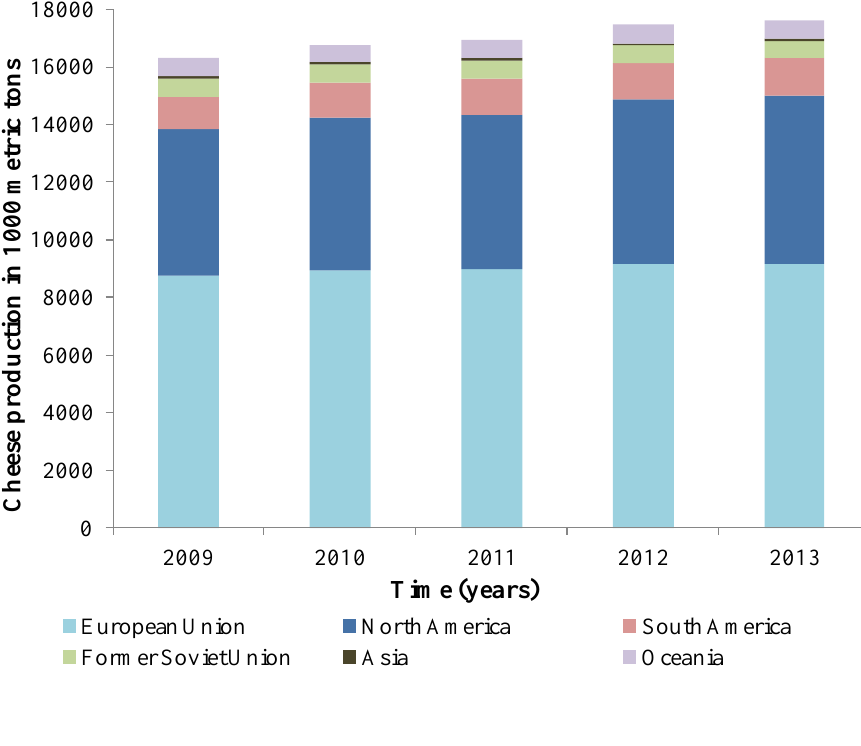
Figure 1. Cheese production for selected countries (in 1000 metric tons). Source: USDA